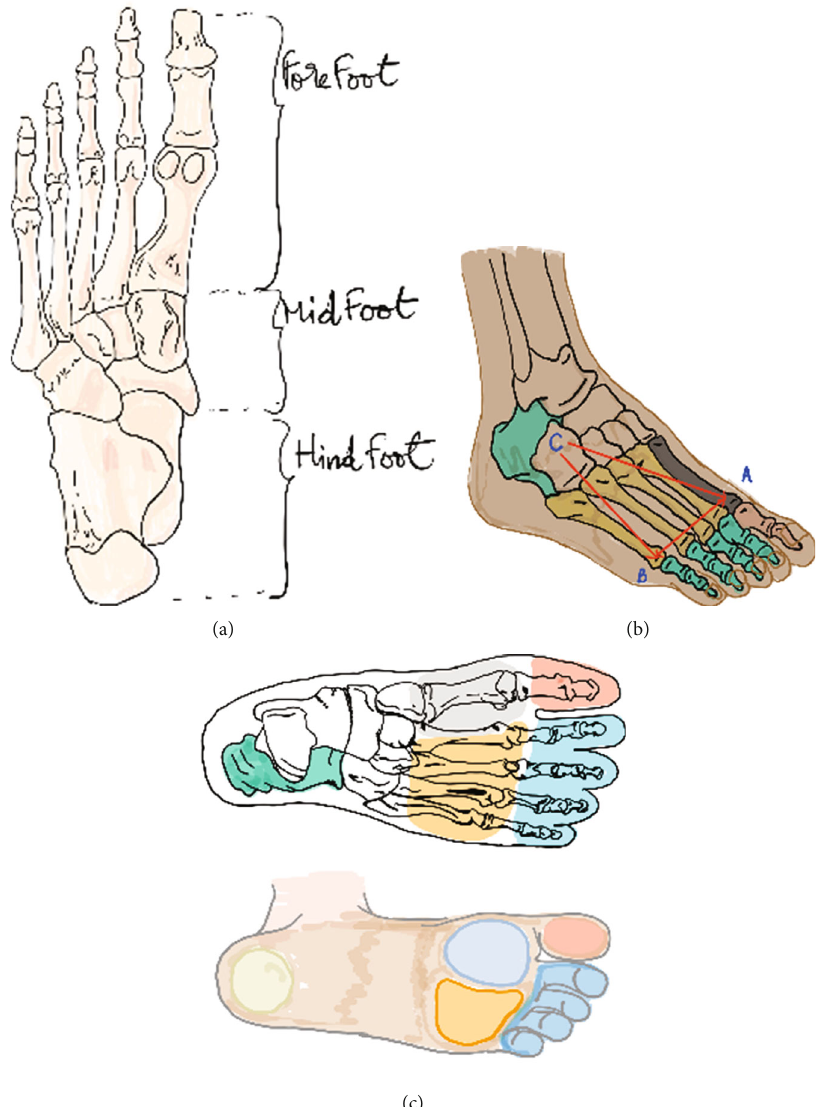
Figure 1: Schematic drawing of the foot regions. (a) Dorsal view, (b) foot weight-bearing tripod, and (c) foot areas of high risk for